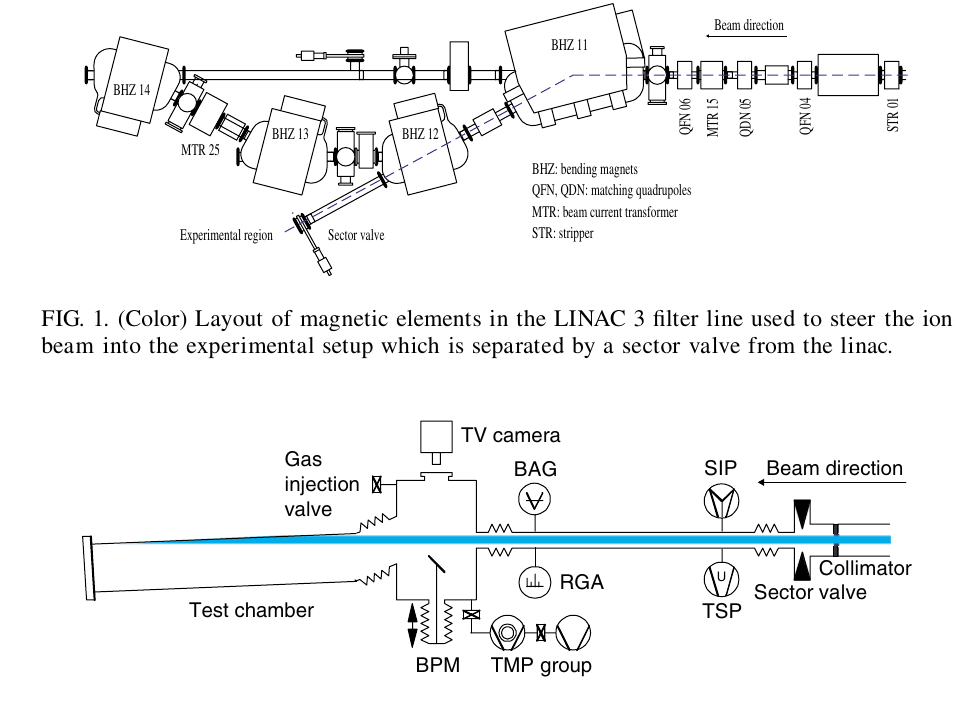
FIG. 2. (Color) The experiment which has been attached at the CERN Heavy Ion Accelerator (LINAC 3) for ion-induced desorption measurements at 4 : 2 MeV = u .